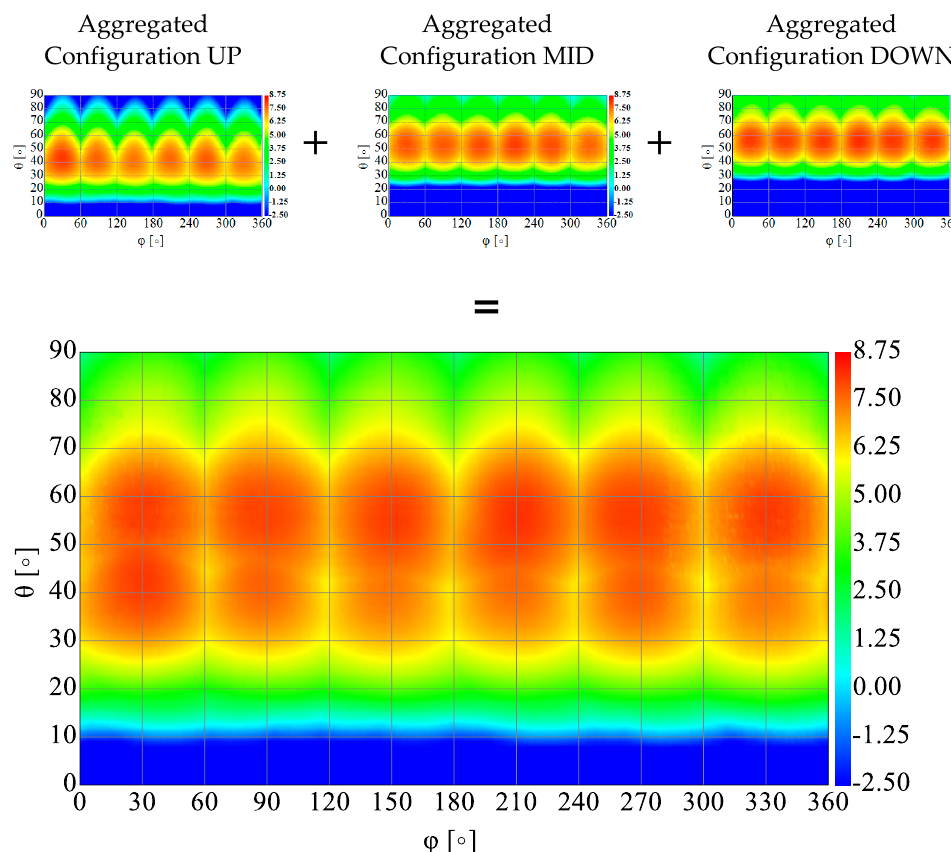
Figure 8. Aggregated gain for all measured configurations.